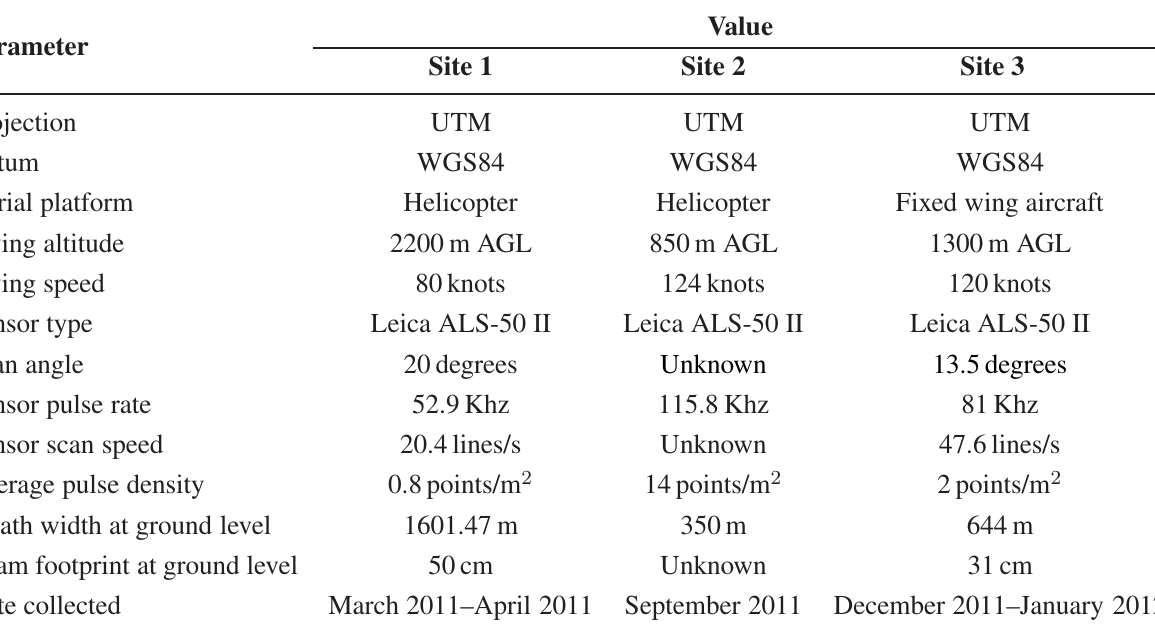
Table 1. Parameters of the LiDAR data used in this